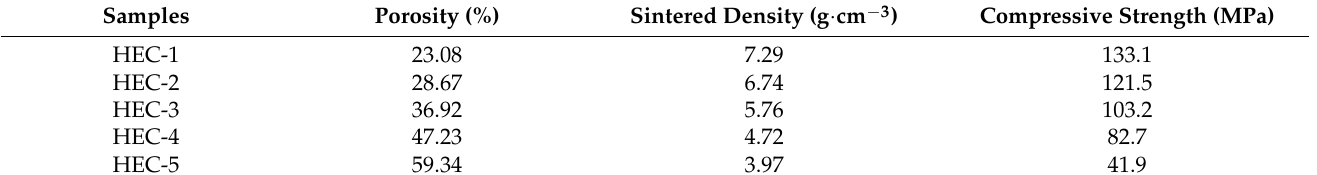
Table 1. Porosity, density, and compressive strength of the obtained porous HECs.